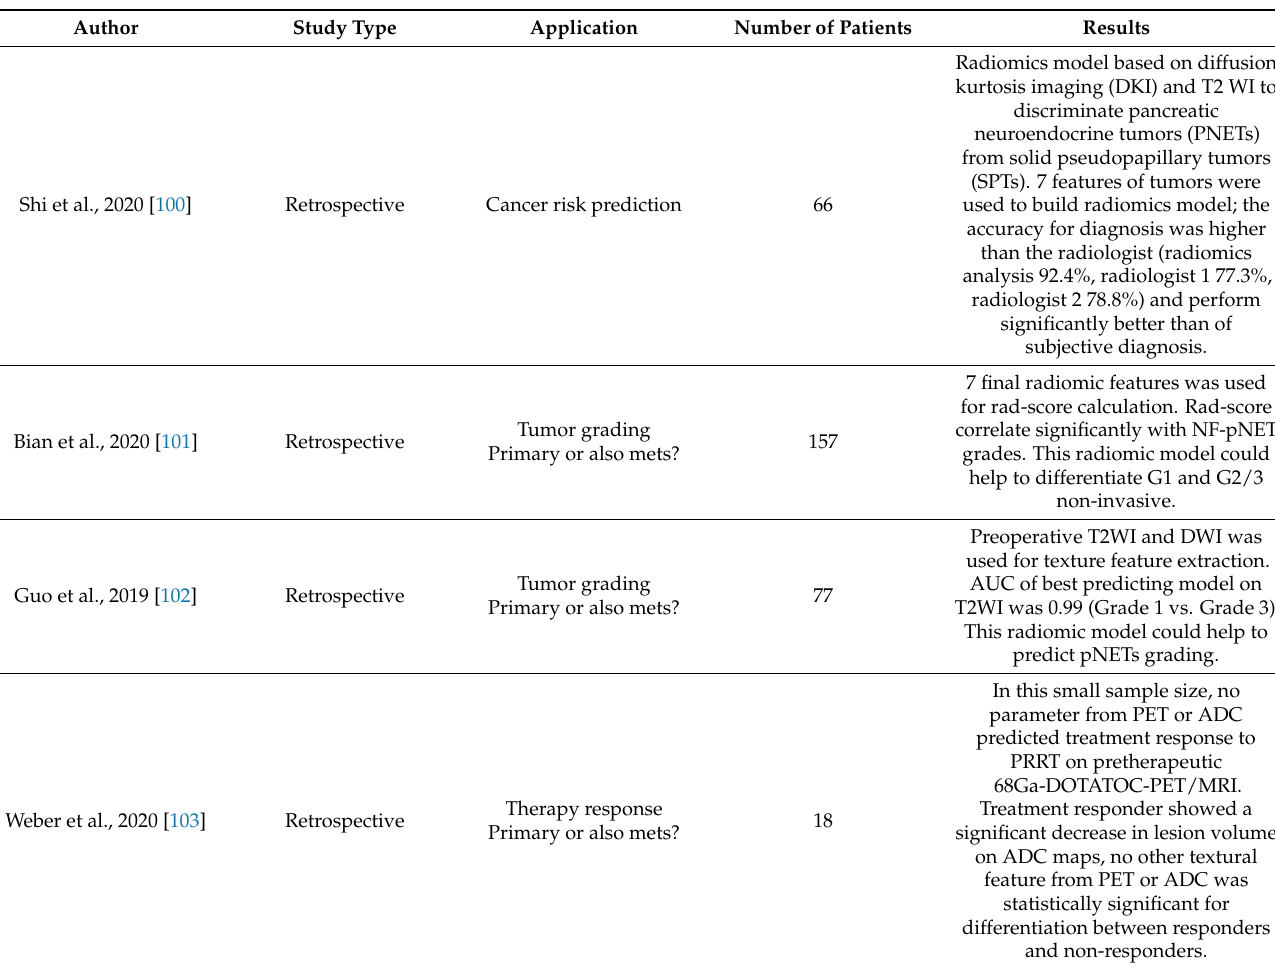
Table 3. Summary of radiomics manuscripts in neuroendocrine tumors related to